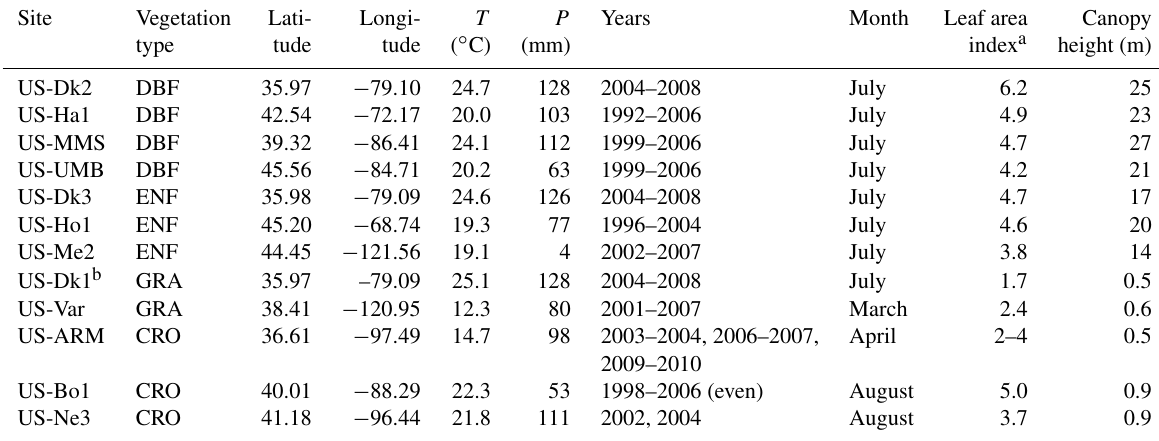
Table 2. Site information for the four deciduous broadleaf forest (DBF), three evergreen needleleaf forest (ENF), two grassland (GRA), and three cropland (CRO) flux towers, including mean temperature ( T ) and precipitation ( P ) for the simulation